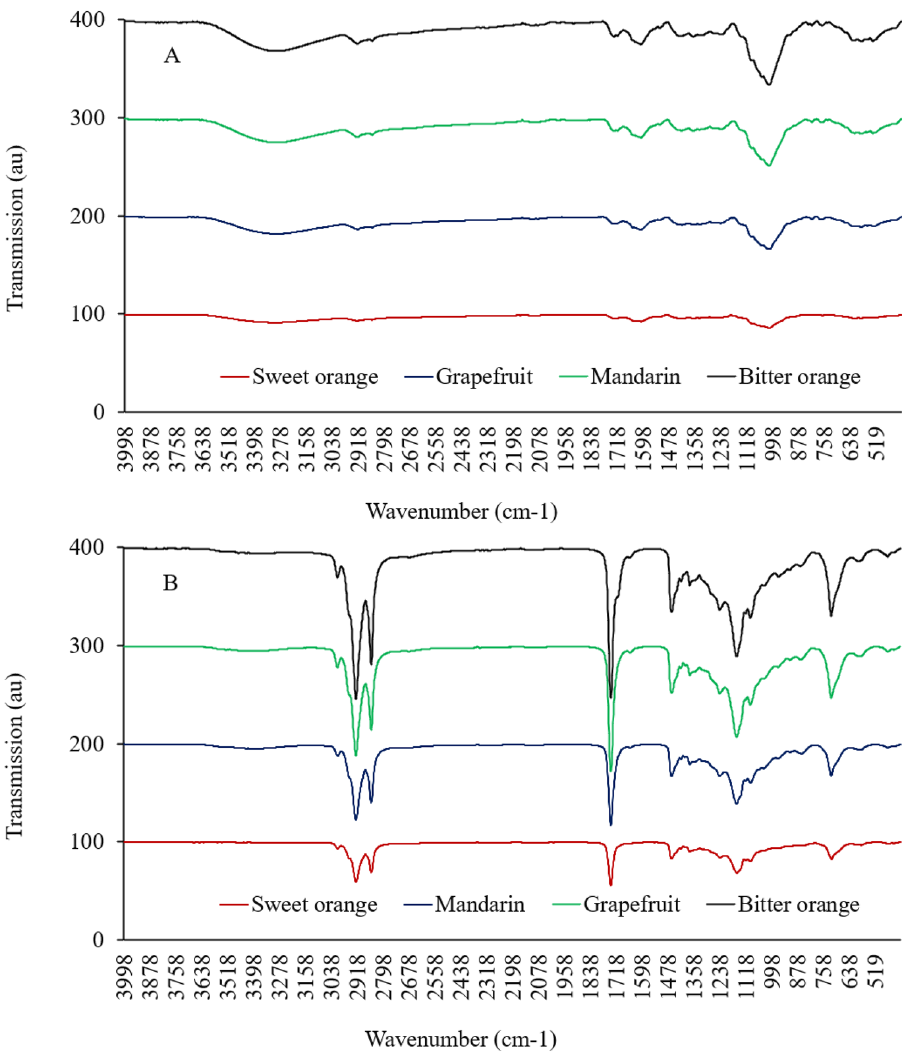
Figure 1. Fourier transform infrared spectrum of peel powder ( A ) and fatty acid ( B ) from bitter orange, sweet orange, grapefruit, and mandarin peels.